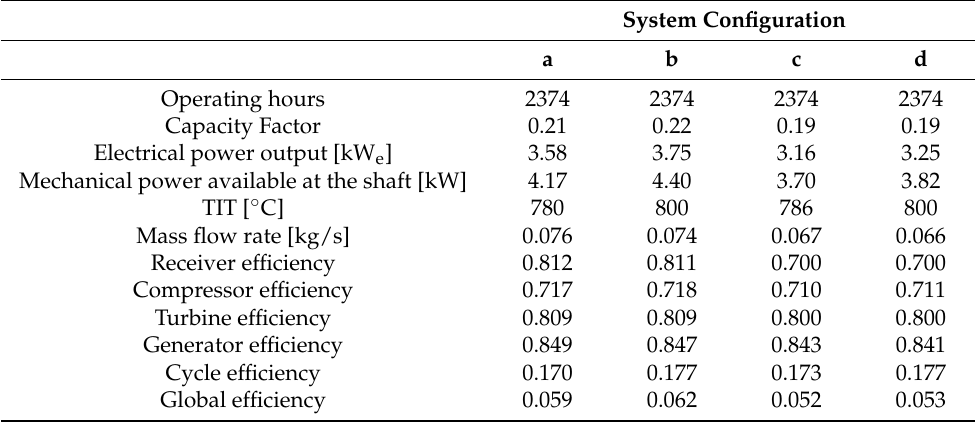
Table 3. Annual average system parameters for the Casaccia site. System configuration: ( a ) volumetric receiver option; ( b ) volumetric receiver option with optimised generator; ( c ) cavity receiver option; ( d ) cavity receiver option with optimised